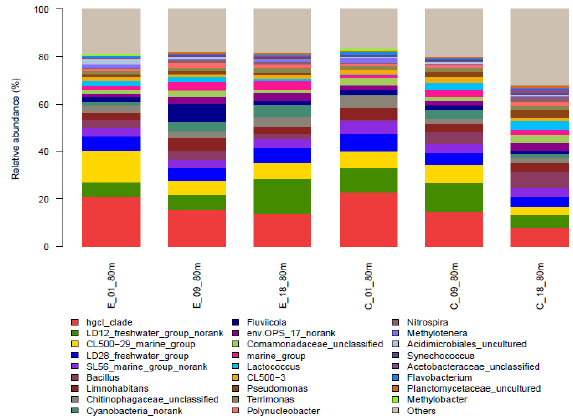
Figure 6. Abundance of the dominating aerobic denitrifying genus in the enhanced and control water layers during the operation of WLAs (“E-01-0m” indicates “enhanced area, the first day of WLAs operation, surface water 0.5 m”; “C-09-90” indicates “control area, the ninth day of WLAs operation, bottom water 90 m”).